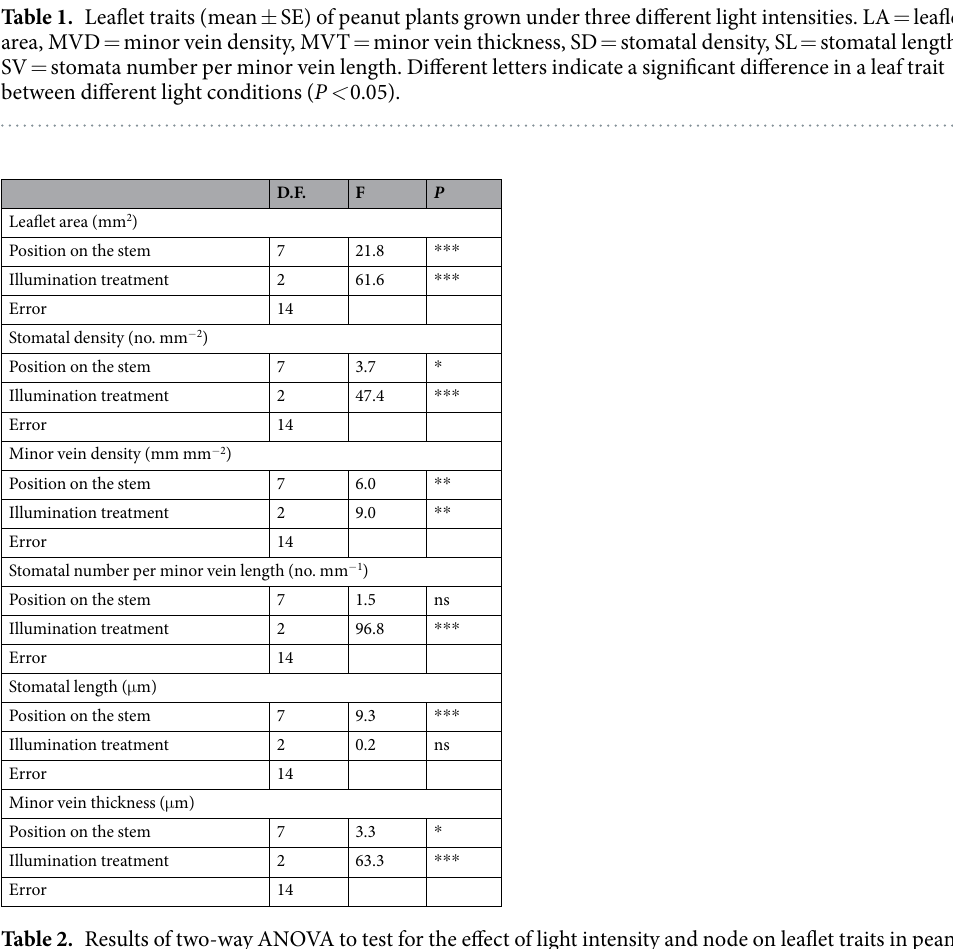
Table 2. Results of two-way ANOVA to test for the effect of light intensity and node on leaflet traits in peanut. D.F. degrees of freedom. * P < 0.05; ** P < 0.01; *** P < 0.001; ns, P >